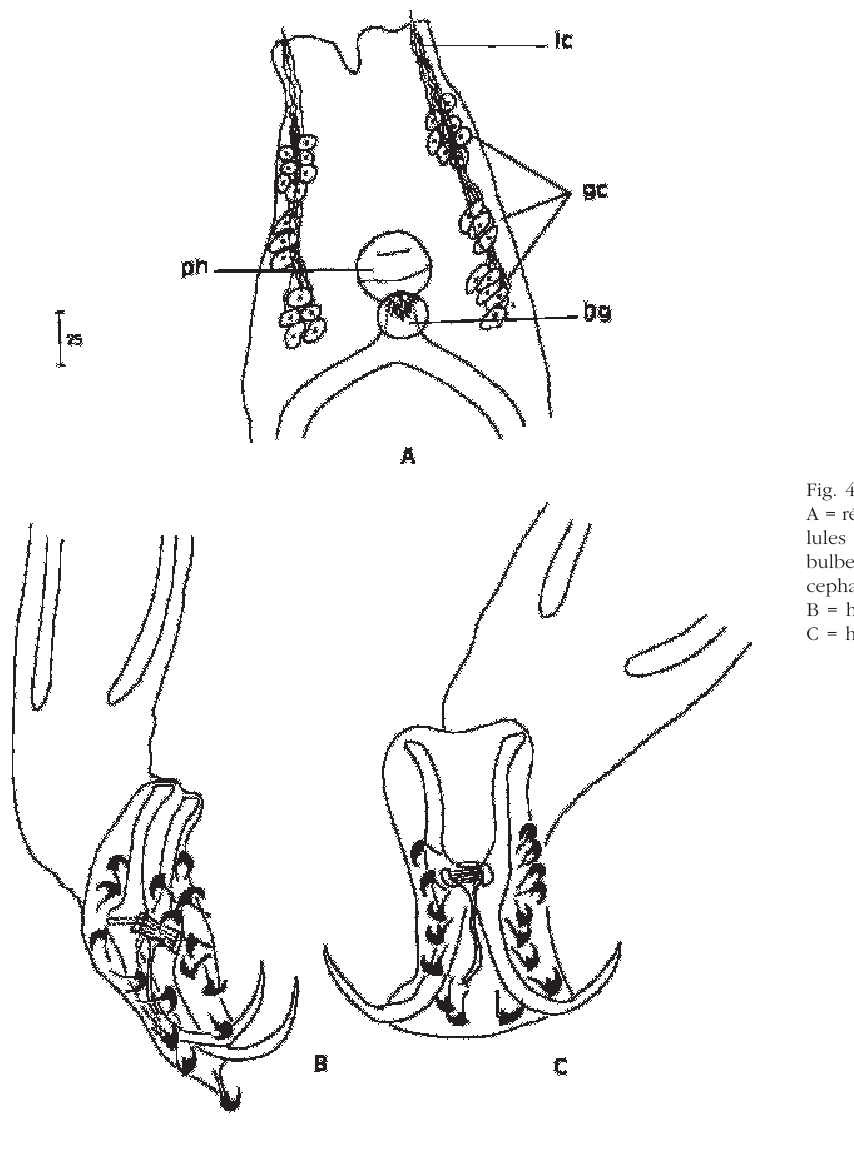
Fig. 4. – Gyrodactylus nyongensis n. sp. A = région antérieure avec la disposition des cel- lules glandulaires des lobes céphaliques (bg : bulbe génital; gc : glades céphaliques; lc : lobe cephalique; ph : pharynx); B = hapteur, vue latérale; C = hapteur, vue